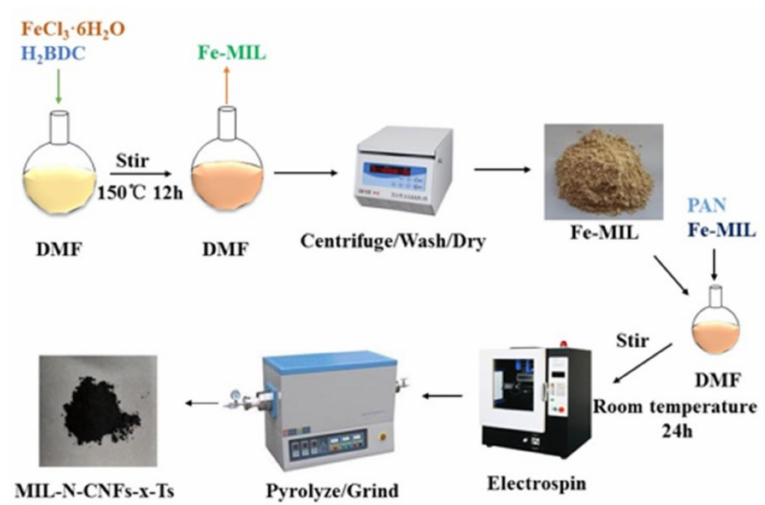
Figure 1. Illustration for the preparation procedures of the MIL-N-CNFs-x-Ts catalysts.